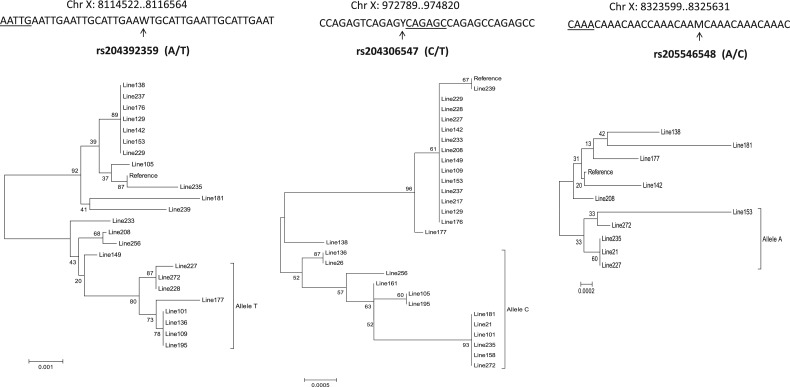
Neighbour-joining phylogenetic trees of microsatellites loci (with 1 kb flanking sequences of both ends) of D. melanogaster inbred lines. The chromosomal positions, the microsatellite repeat and the SNP position within the microsatellites (upward arrow) are shown on the top of each tree. The sequence origins (inbred line # or the reference genome) are also shown for each branch along with bootstrap support values. The phylogenetic grouping of D. melanogaster lines that carry the alternative allele of the SNP is also shown. The scale of branch length is shown below each tree.